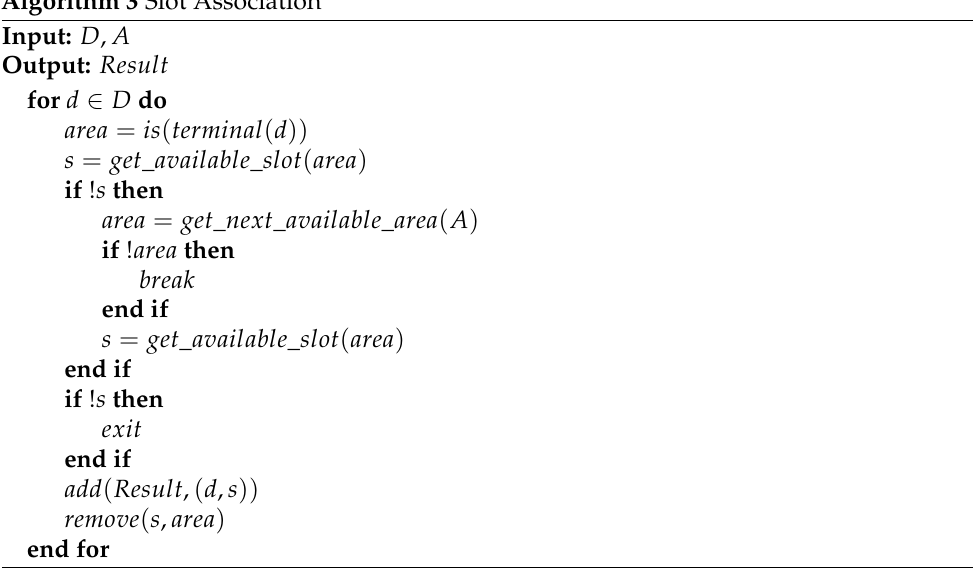
Algorithm 3 Slot Association